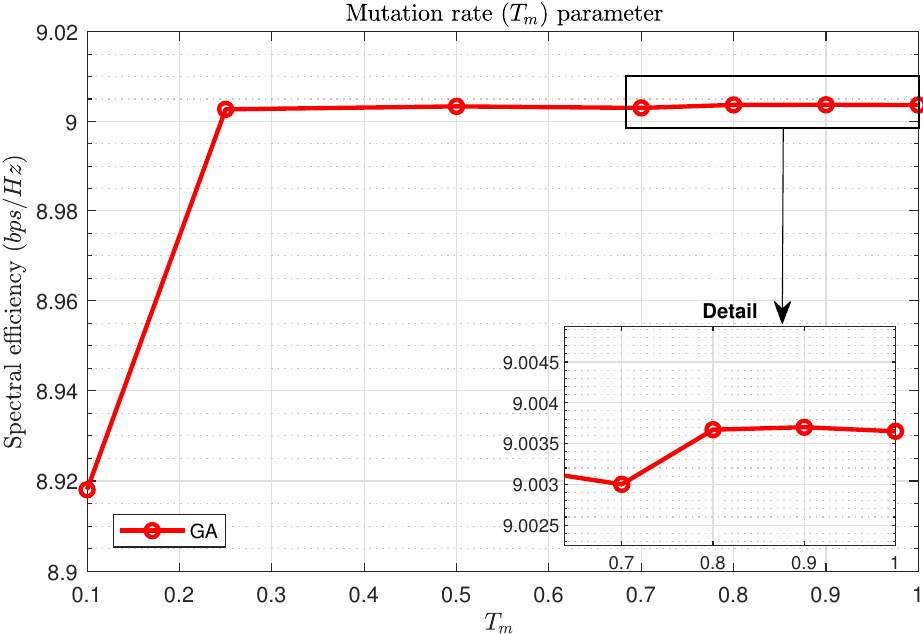
Figure 7. Results of tests to find the better parameters to T m ( K = 20, R = 1000